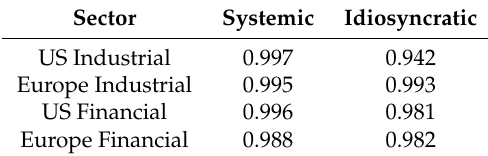
Table 17. Correlation coefficients between alternative estimates of the relevance of risk